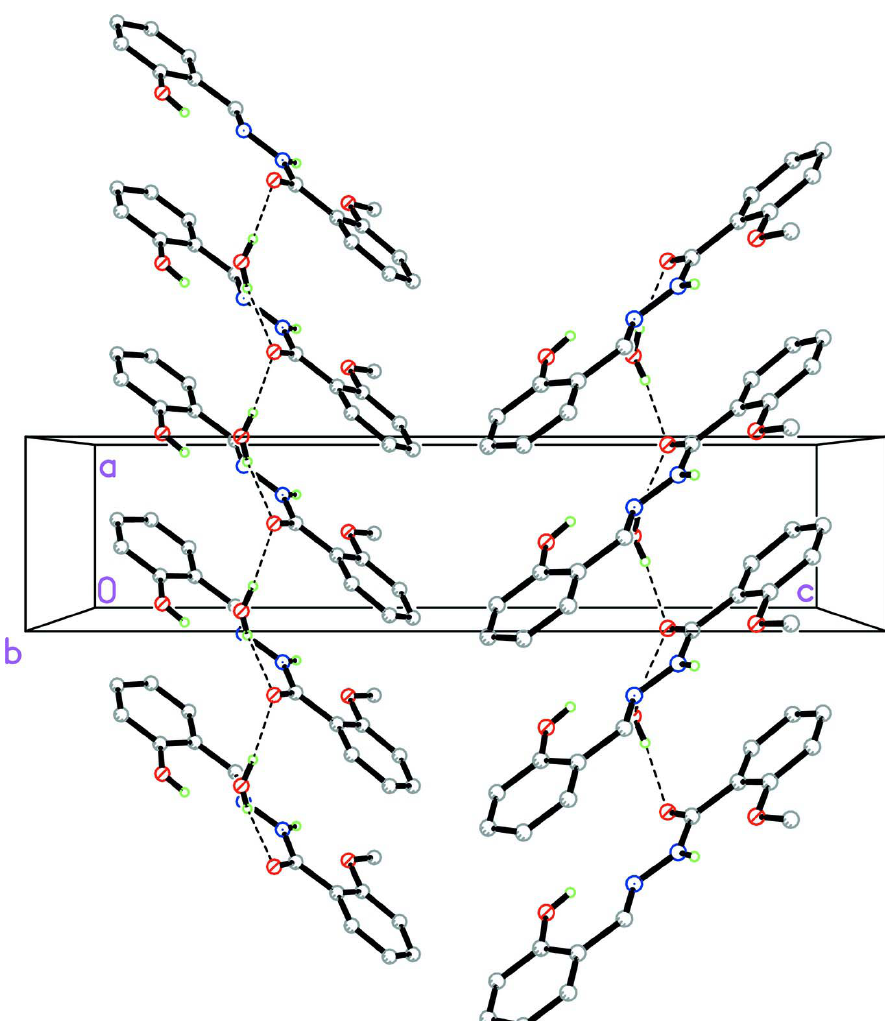
The crystal packing of the title compound, viewed approximately along the b